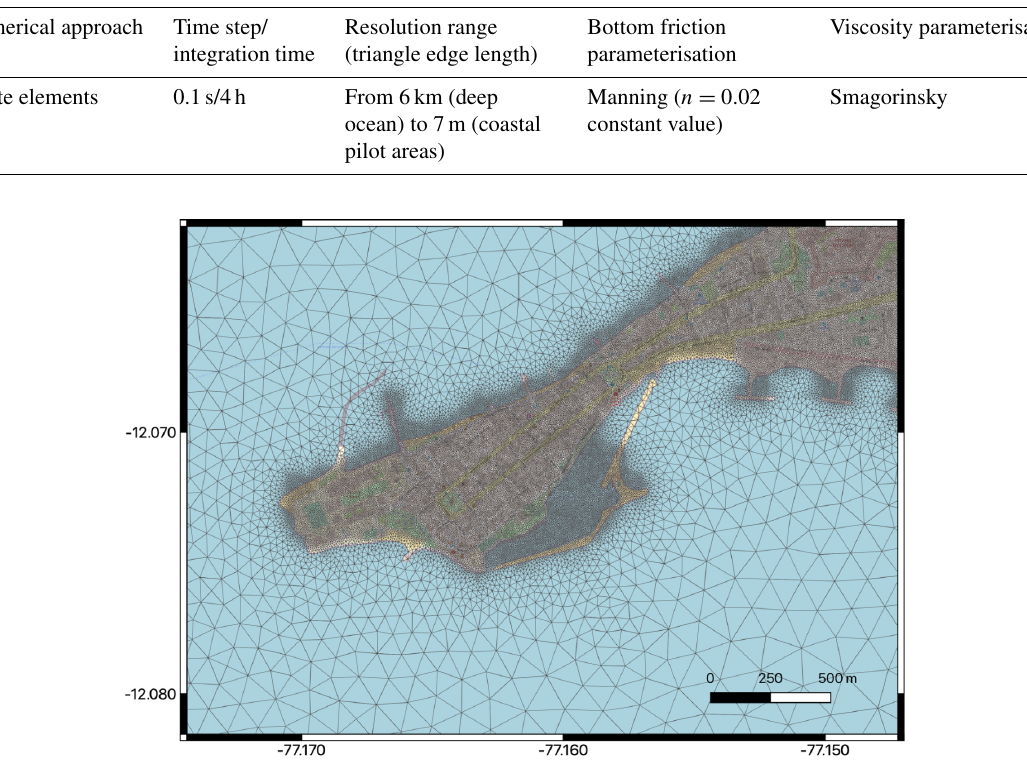
Figure 2. Section of the triangular mesh used for the TsunAWI simulations in the La Punta sector (Callao district). The mean resolution in the pilot area is approximately 20m, whereas the shortest edge length measures about 7m. The basemap and data are from © OpenStreetMap contributors 2021. Distributed under the Open Data Commons Open Database License (ODbL) v1.0.